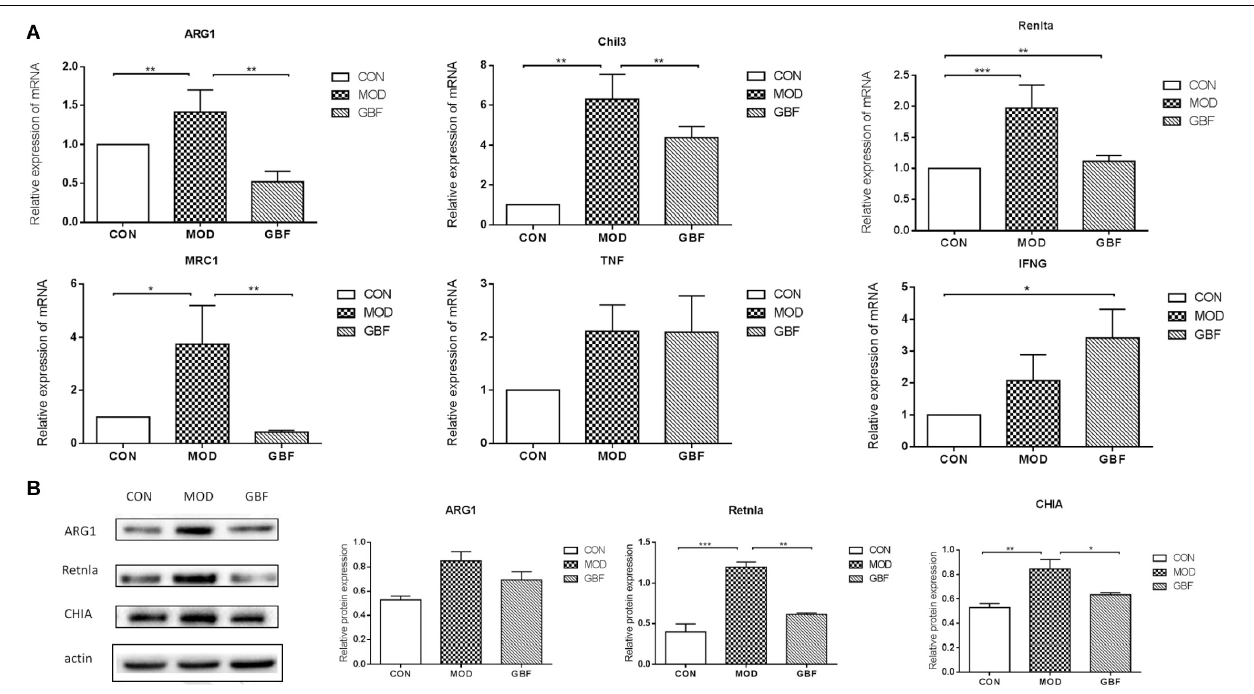
FIGURE 5 | Validation of differentially expressed candidate proteins identified using proteomics. (A) qRT-PCR of six selected genes presented relative to control samples and normalized against GAPDH in each sample. (B) Western blot analysis shows decreased ARG1, Retnla, and CHIA levels in the GBFXD group (B). Values represent the means ± SE of three independent experiments with ≥ 3 replicates per experiment. ∗∗ p < 0.01; ∗∗∗ p < 0.0001; ∗∗∗∗ p <